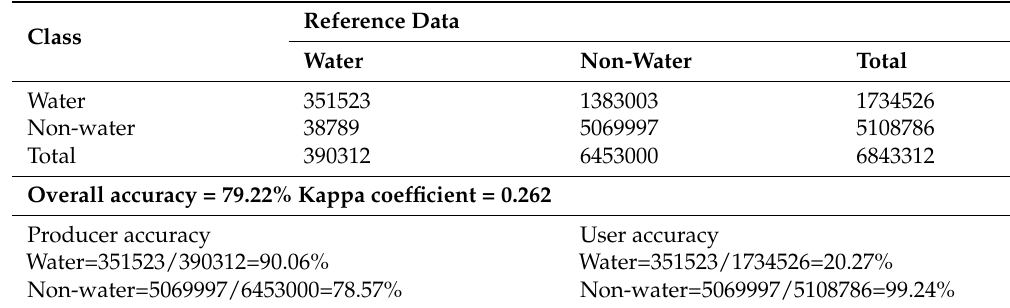
Table 3. Error matrix of the ALG1 classified image (Dataset 1).